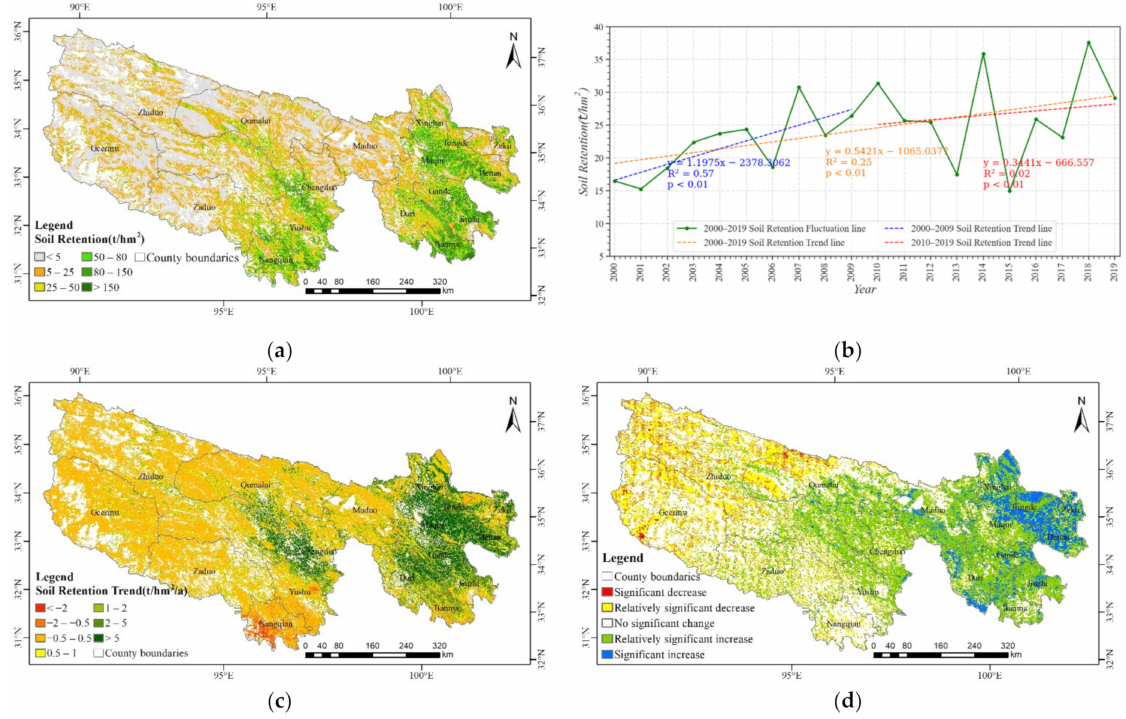
Figure 7. Spatial distribution of average annual soil retention ( a ), inter-annual changes ( b ), change trend ( c ), and significance ( d ) of ecosystems in the TRHR from 2000 to